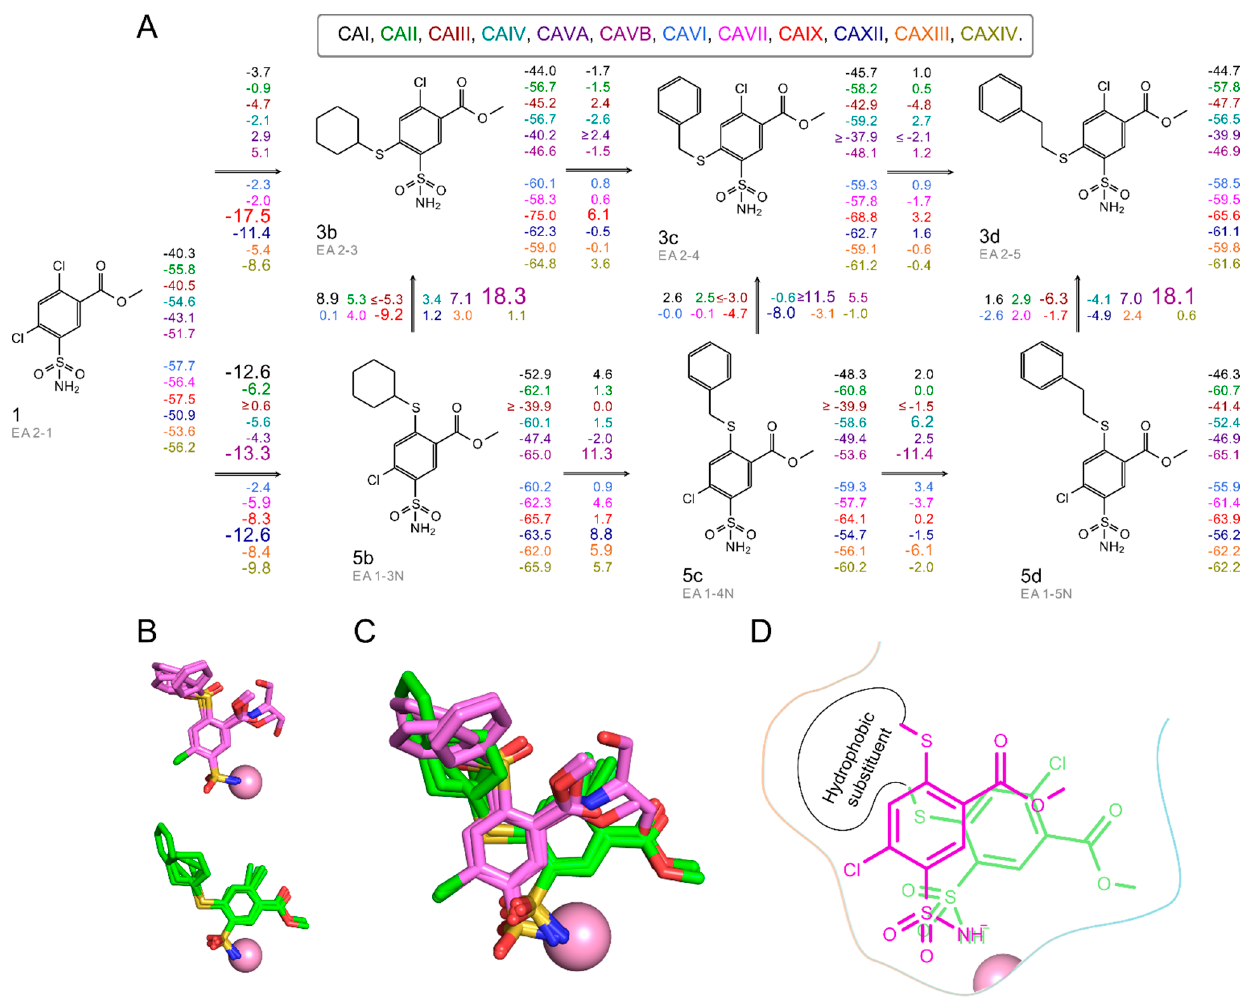
Figure 4. Correlation of compound chemical structures with the changes in standard intrinsic Gibbs energy upon binding and comparison of the crystal structures between CA isozymes. ( A ) Differences of Δ G intr (kJ/mol) between neighboring compounds are listed on the connecting arrows. Colors represent CA isozymes. ( B ) Superimposed ligands of these crystal structures: (upper panel) para - substituted ligands are colored magenta: CAXII— 3b (PDB ID: 7PP9), CAXII— 3d (PDB ID: 7PUW),